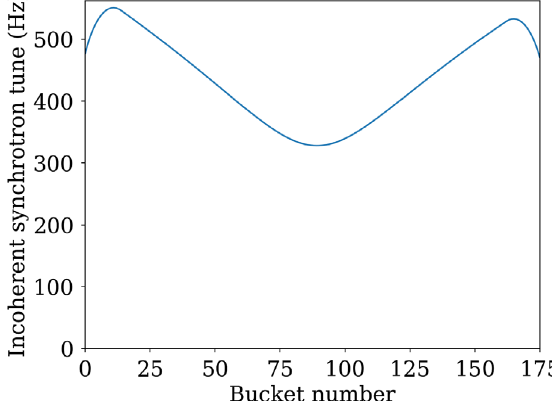
FIG. 6. The synchrotron frequency calculated for each bunch from the derivative of the total local rf voltage.